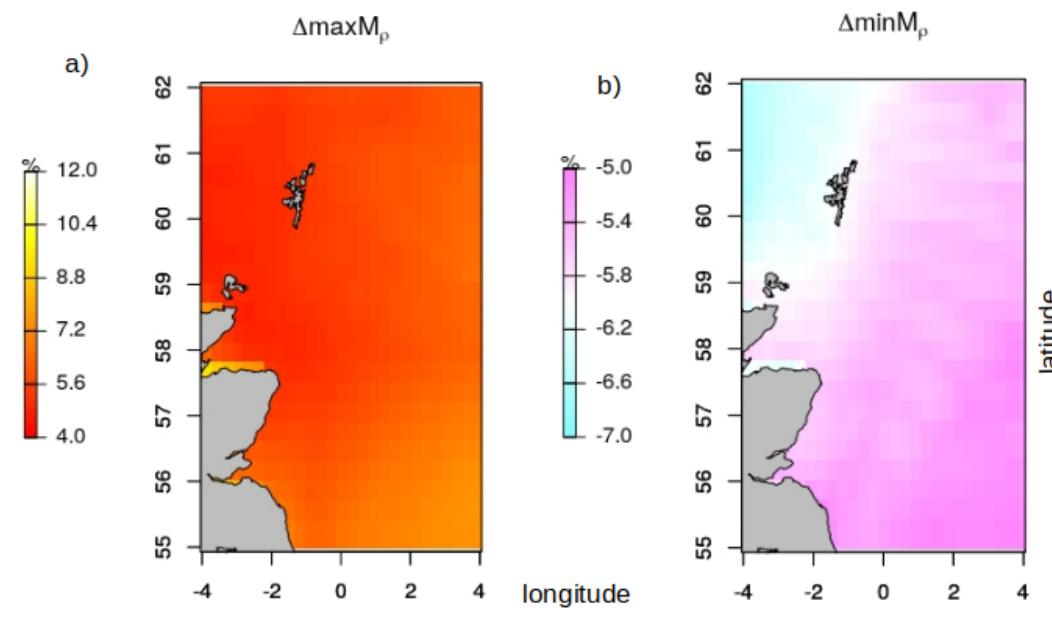
Figure 5. ( a ) Minimum to mean air density variation ∆ minM ρ ; ( b ) maximum to mean air density variation ∆ maxM ρ in the study